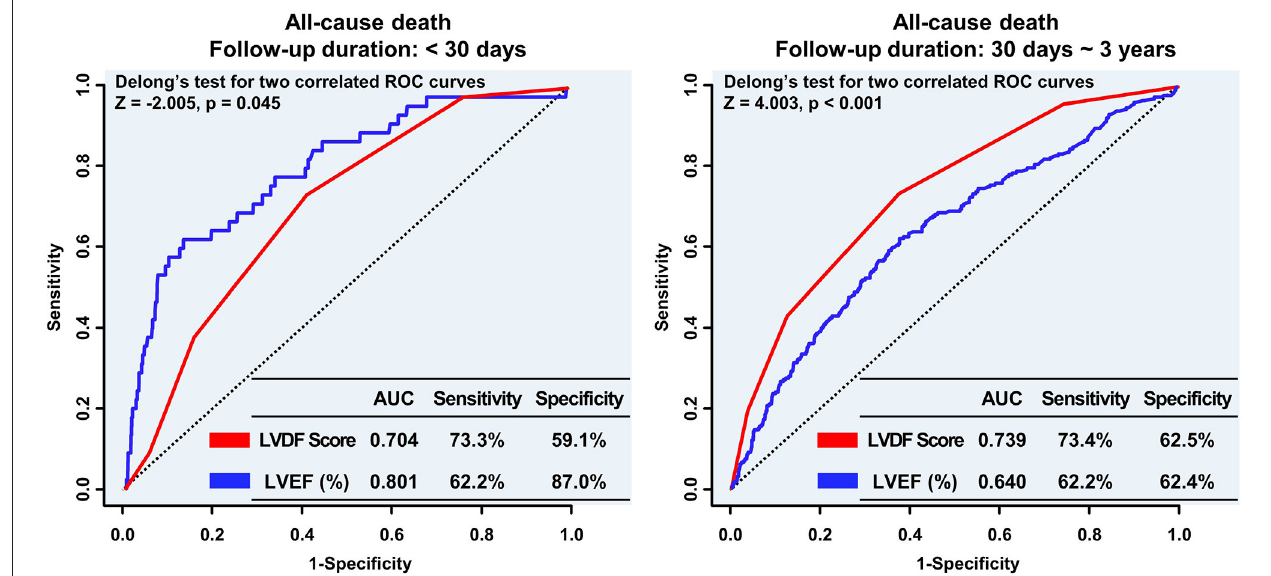
FIGURE 5 | Landmark analyses of the ROC curve to compare the LVDF score and LVEF before and after the 30-day follow-up period. In the landmark analysis, LVEF was the strongest predictor of all-cause mortality during the short-term follow up; however, the LVDF score was a better predictor of mortality than LVEF during the long-term follow-up. AUC, area under the receiver operating characteristic curve; LVDF, left ventricular diastolic function; LVEF, left ventricular ejection fraction; ROC, receiver operating